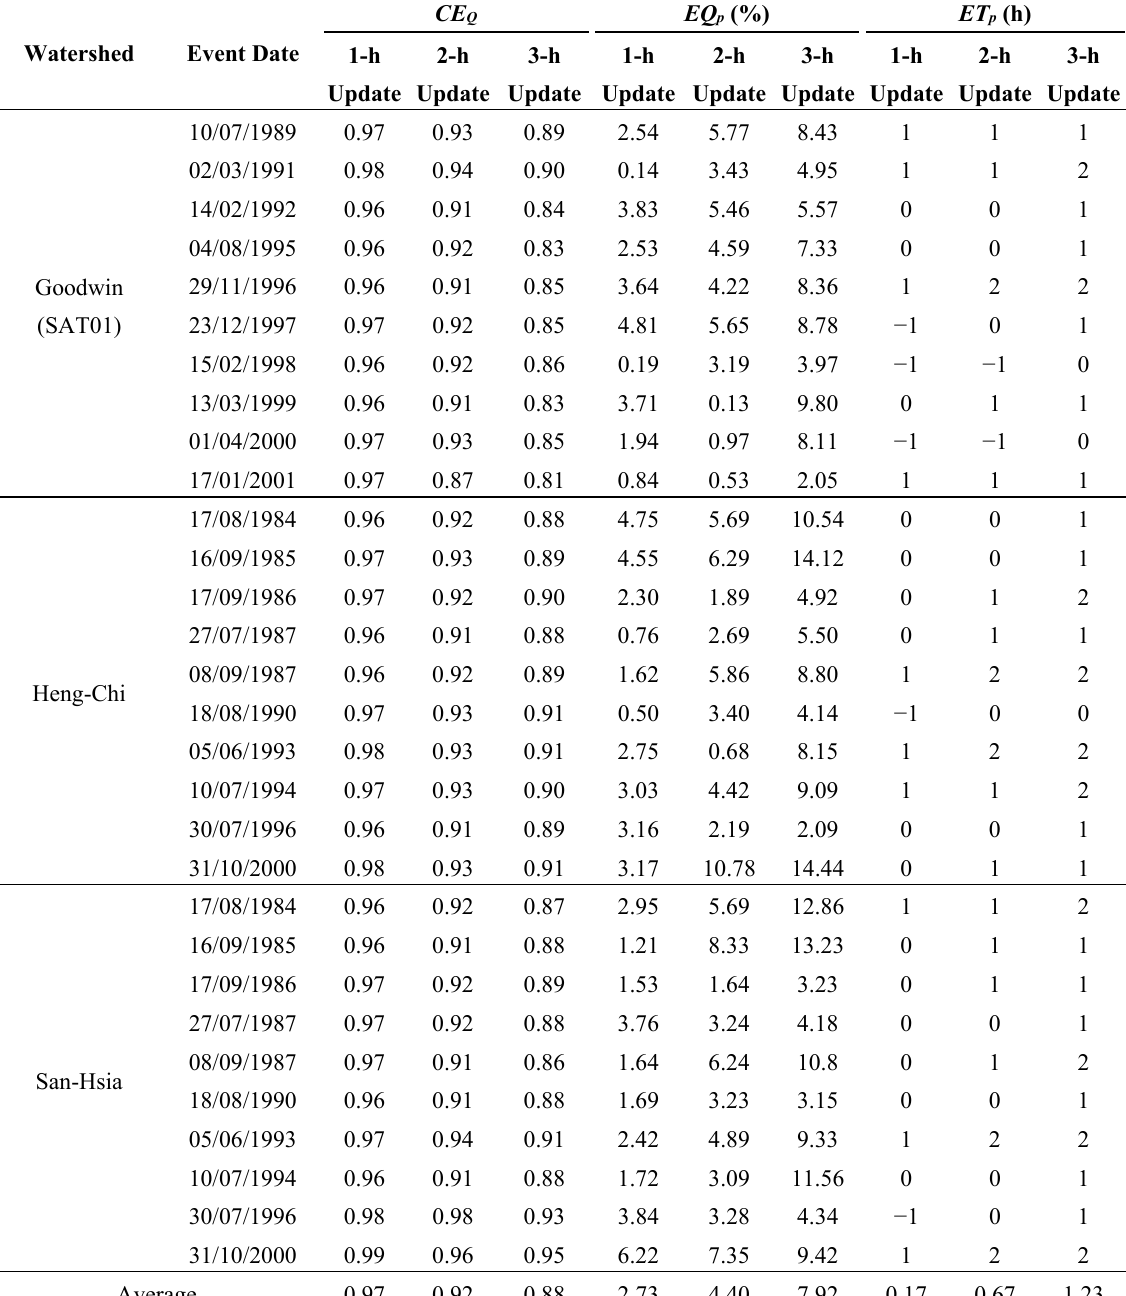
Table 6. Results of flow forecasting using measured rainfall and flow updating technique. Watershed Event